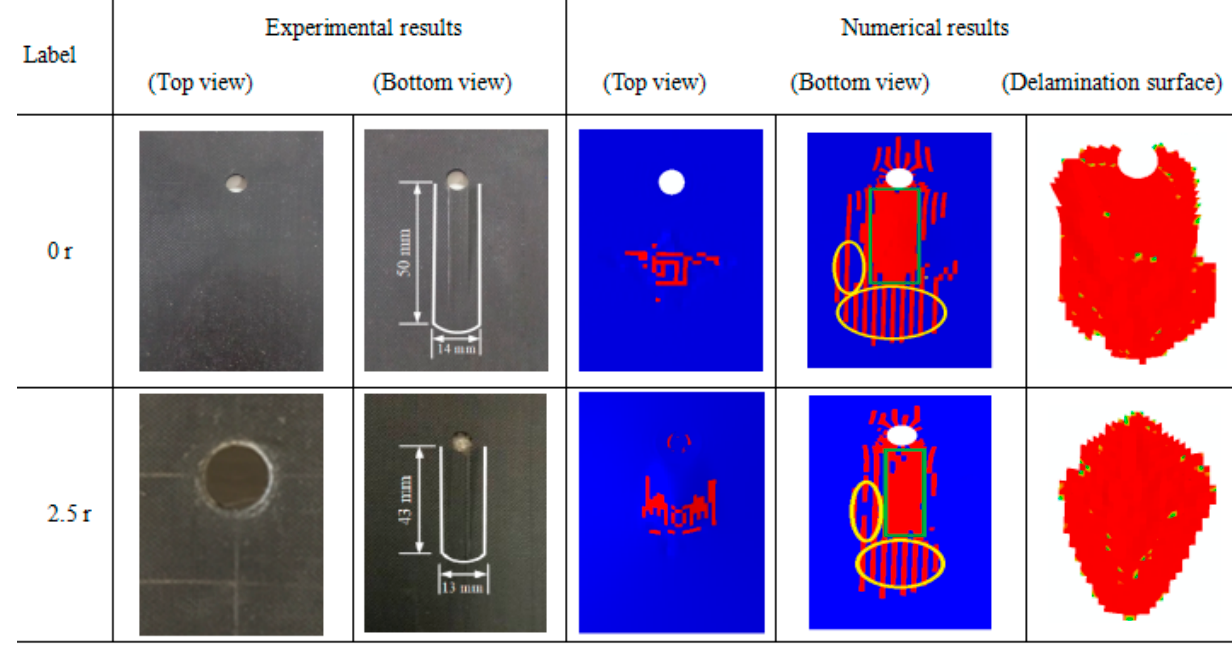
Figure 9. Matrix tensile and delamination surface damage from the experimental and numerical simulations.